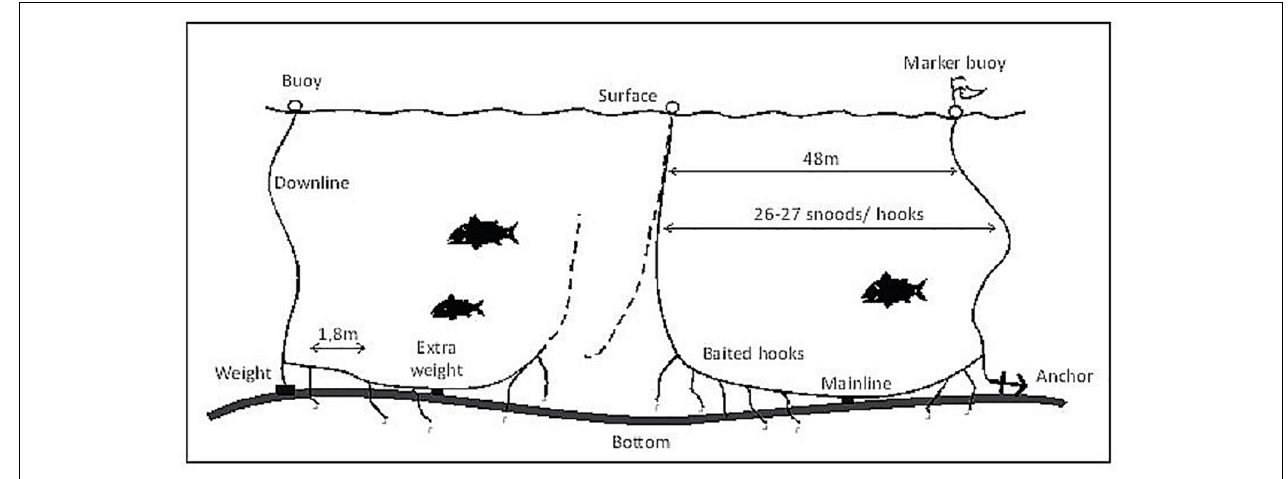
FIGURE 2 | Bottom longline experimental design showing both ends.